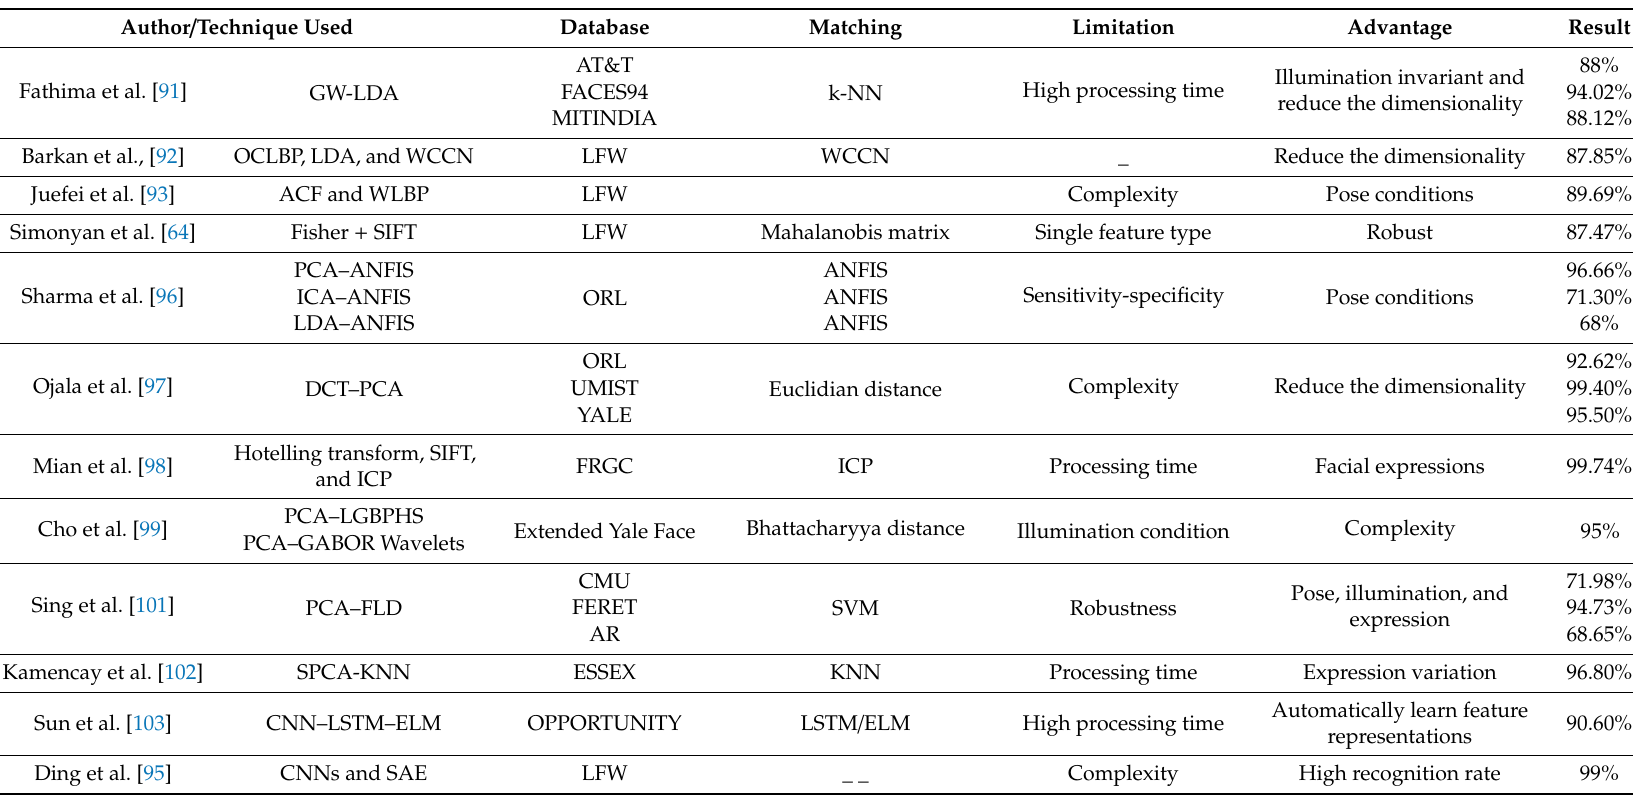
Table 3. Hybrid approaches. GW, Gabor wavelet; OCLBP, over-complete LBP; WCCN, within class covariance normalization; WLBP, Walsh LPB; ICP, iterative closest point; LGBPHS, local Gabor binary pattern histogram sequence; FLD, Fisher linear discriminant; SAE, stacked